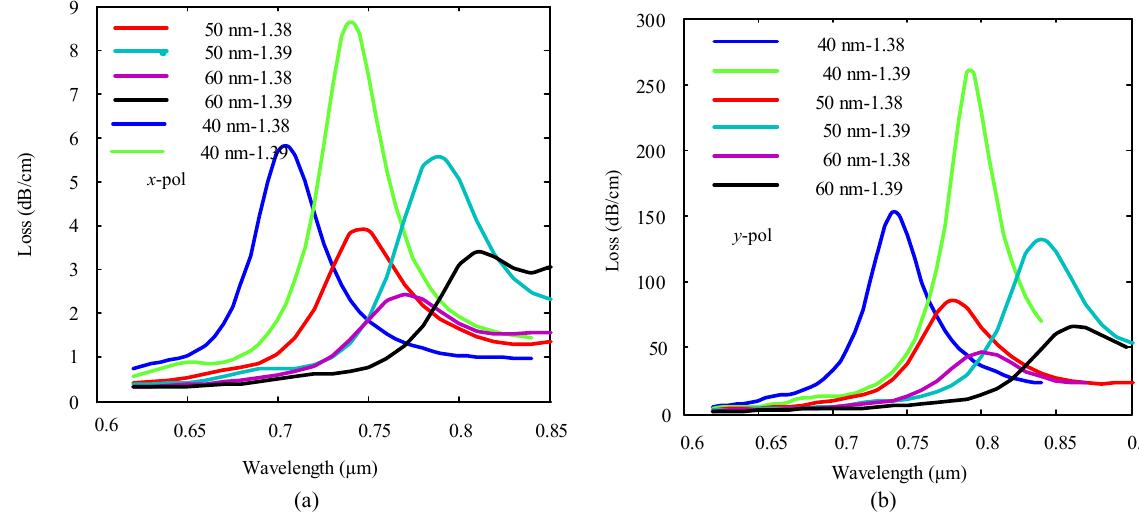
Fig. 7 Loss spectra as a function of wavelength with different gold layer thicknesses for: (a) x- and (b) y- polarized